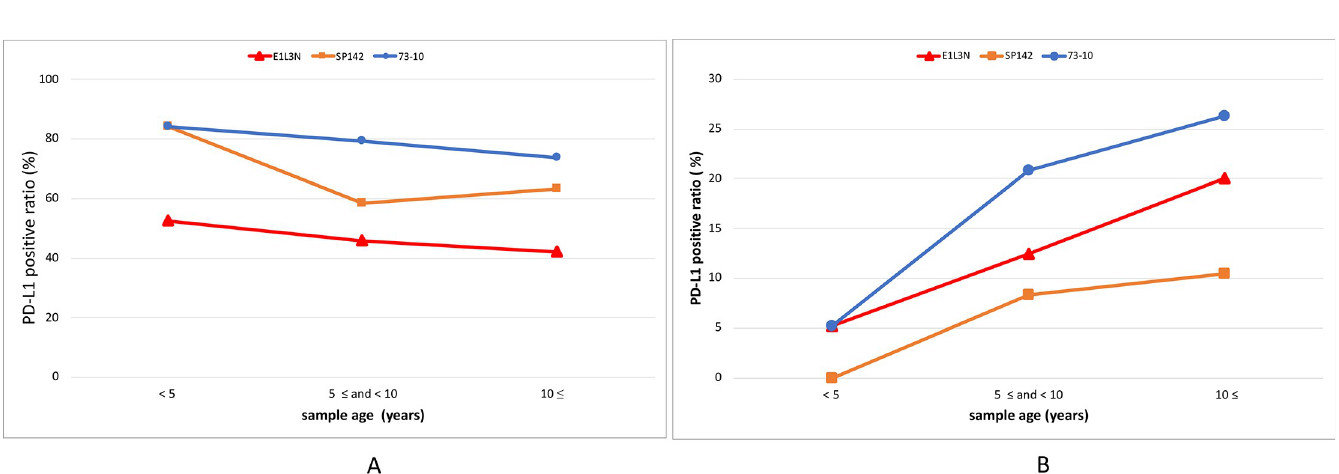
Fig 5. Comparison of PD-L1-positive ratio on immune cells (A) and tumor cells (B) based on sample age.